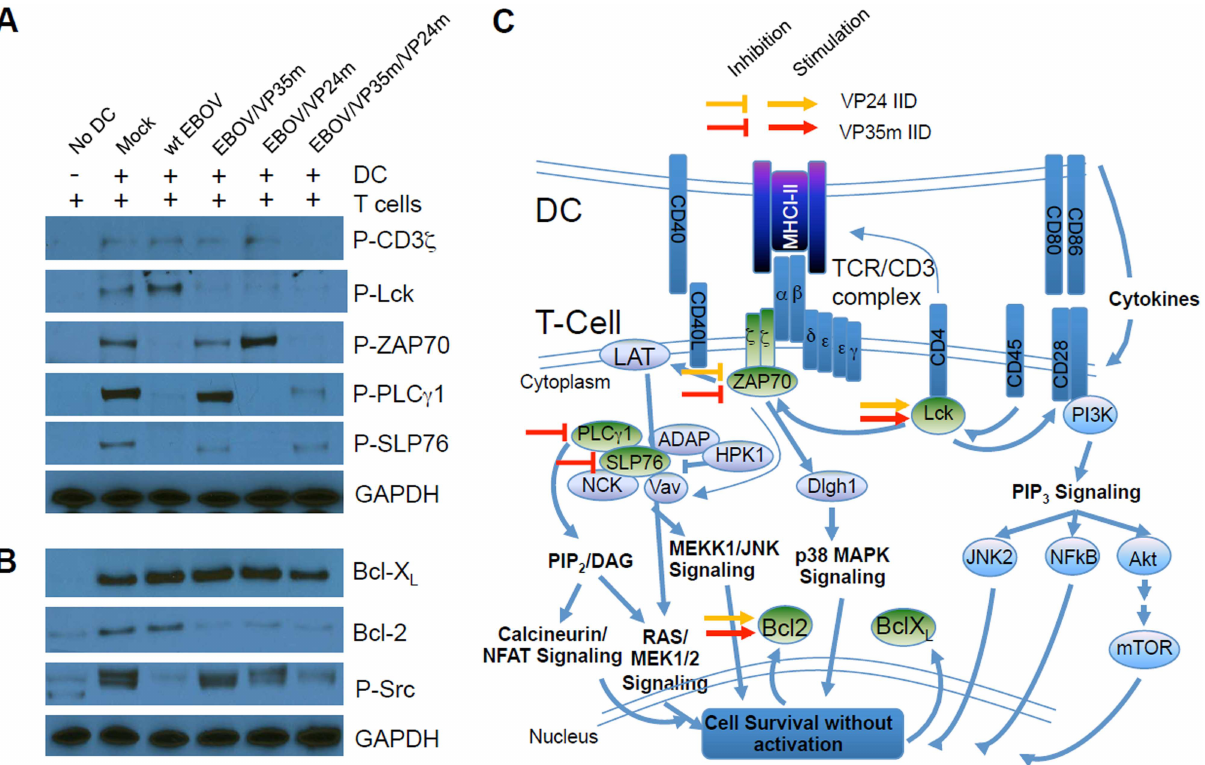
Fig 8. VP35 and VP24 IID block phosphorylation of TCR complex-associatedadapters and downstream signal molecules. CD4 + T cells were co-cultured with DCs infected with wt EBOV or the mutated viruses for 4 days, and TCR signal transduction was analyzedby Western blotting of phosphorylated adaptermoleculesand downstreamsignalingmolecules( A ) and anti-apoptotic Bcl-2 family members and the SRC molecule( B ). C . Map of signalingcascades associatedwith MHC-TCR engagement that promotes transduction of survival signalsin the absenceof antigen-dependentproliferation accordingreference [95]; the map itself is adaptedfrom Cell SignalingTechnology web site (http://www.cellsignal.com). As shown in panel A, basal phosphorylation of adapter moleculeswas observed followingculture of autologous CD4 + T-cells with mock-DCs. The identifiedVP24 and VP35 IID-mediated blocks and stimulationsof signaltransduction are shown; note that block of signal transduction is associatedwith altered DCs